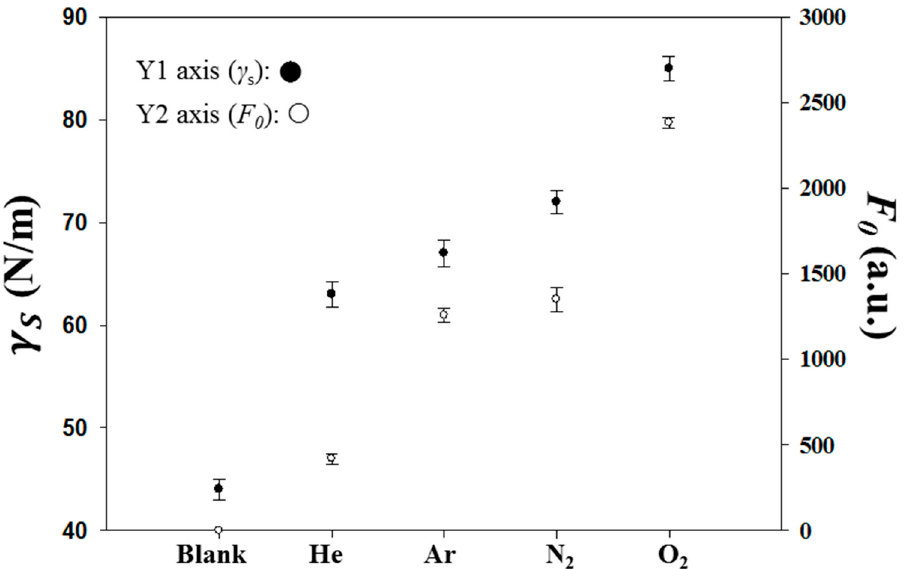
Figure 2. The dependence of various plasma gases on the total surface free energies, γ S ( • ), of the PI substrates and on the fluorescence intensity, F 0 ( ○ ), of the Tc-stripped MIP-plasma-PIs. The plasma was powered at 90 W for 1.0 min with a gas flow of 10 sccm.